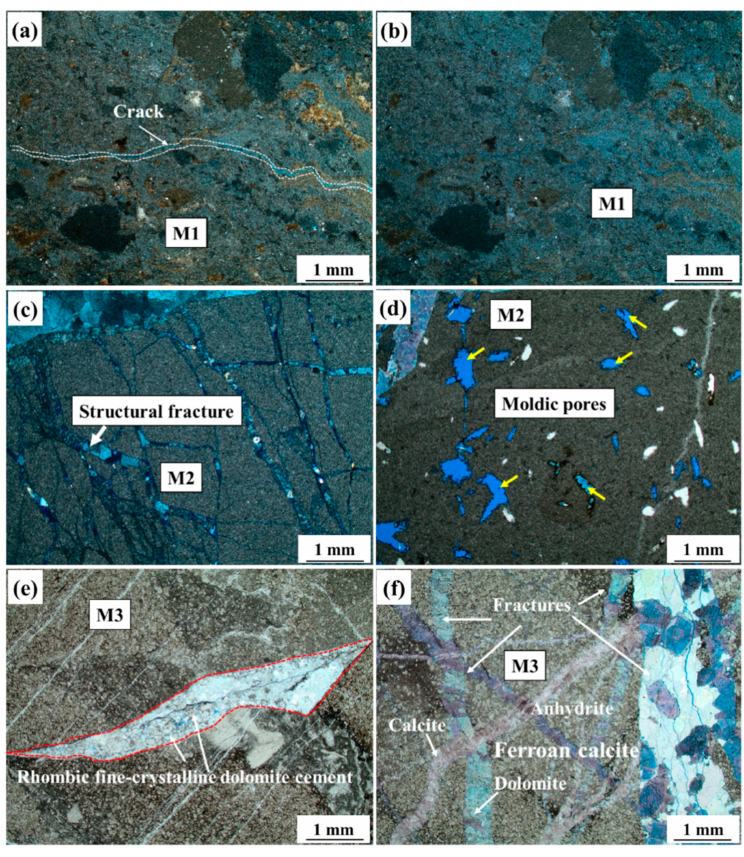
Figure 2. Petrological characteristics of various matrix dolomites in the Lower Paleozoic strata in the Dongying Depression, Bohai Bay Basin. ( a ) Argillaceous dolomite (M1), Well